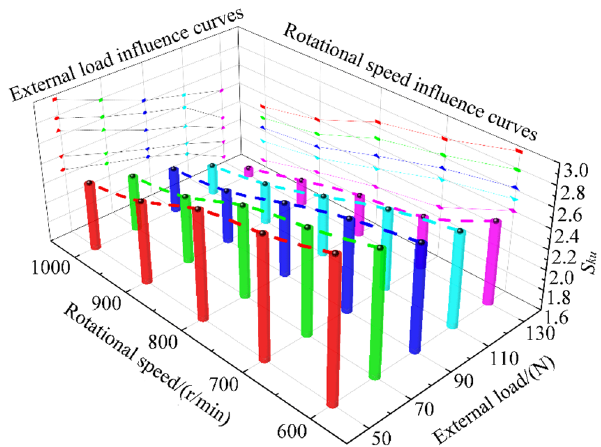
Figure 18. Effect of friction parameters on surface kurtosis. (red is the value of S ku at different rota- tional speeds at 50N, green is the value of S ku at different rotational speeds at 70N, blue is the value of S ku at different rotational speeds at 90N, light blue is the value of S ku at different rotational speeds at110N, and pink is the value of S ku at different rotational speeds at 130N).